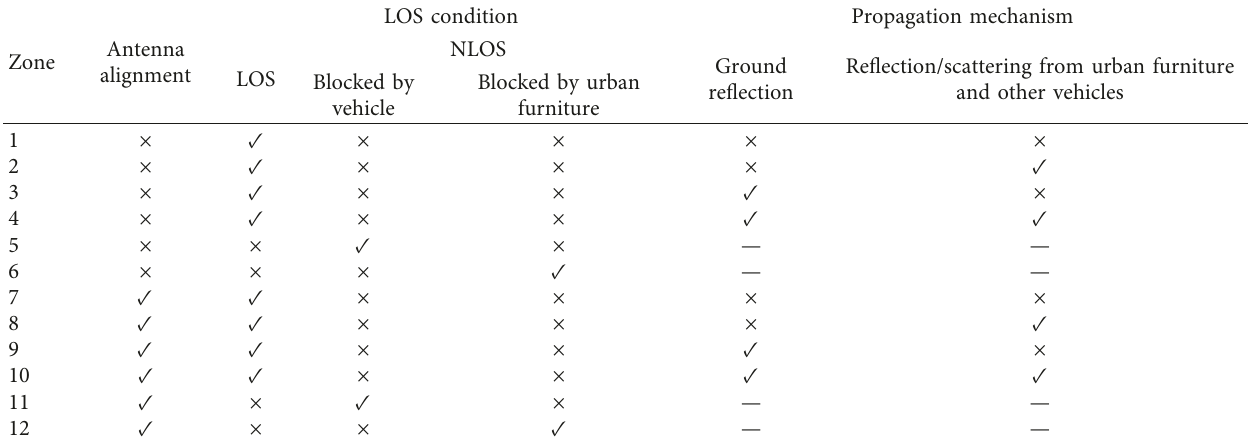
Table 6: Zones of simulation